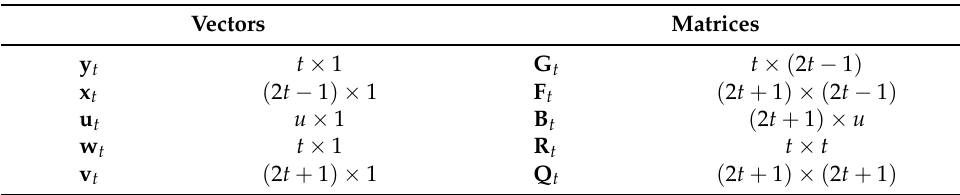
Table 4. Dimensions in the state space model of Verrall